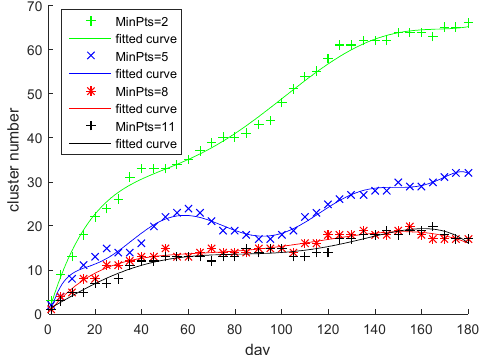
Figure 13. Dependence of the number of clusters with time for four MinPts settings. MinPts is the minimum number of trajectories to form clusters.